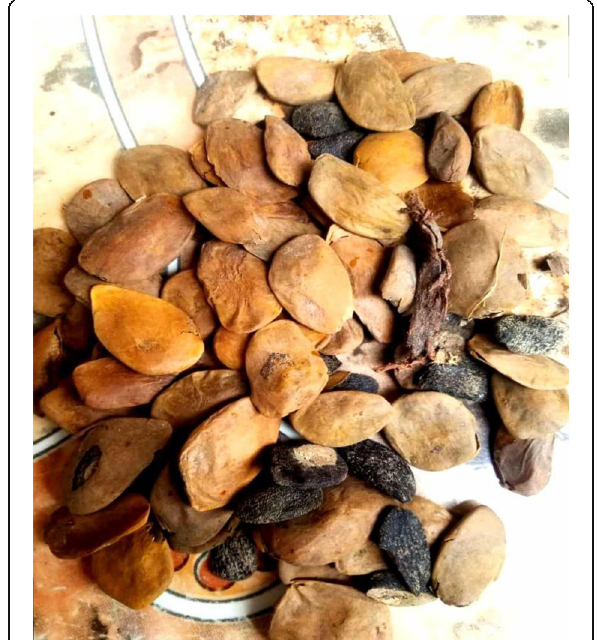
Fig.2 H. umbellate seeds